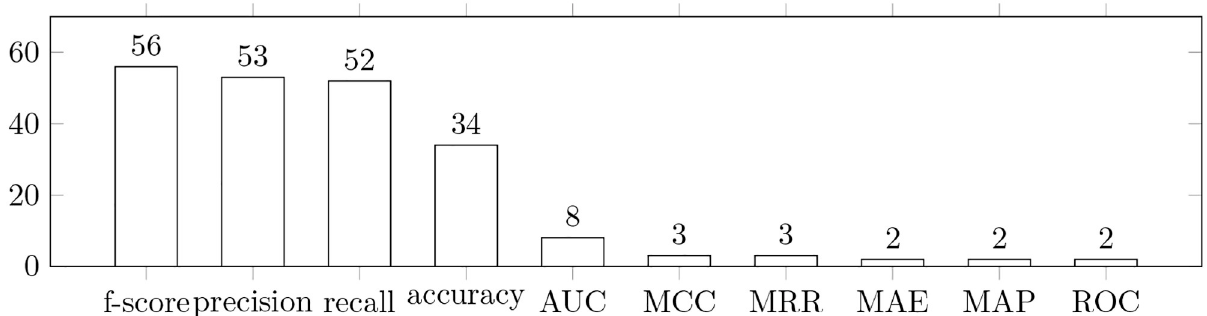
Fig 11. Metrics used in the papers included in the final reading log. The bars show the number of papers in which the specified metrics were used. Note: several metrics could be used in one paper. Acronyms used: AUC—area under the ROC curve, MCC—Matthews Correlation Coefficient, MRR— mean reciprocal rank, MAE—mean absolute error, MAP—mean average precision, ROC—receiver operating characteristic curve.